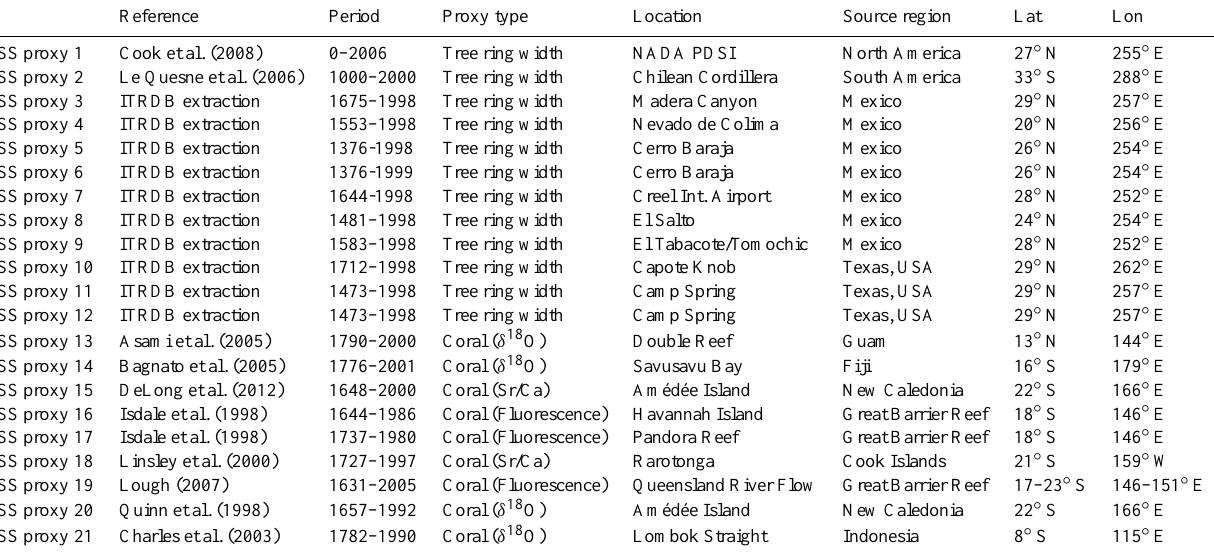
Table 3. The single station (SS) temperature and/or rainfall proxies employed in this study. Note that these proxies have at least annual resolution and are pre-screened such that they have a correlation of at least 0.3 with the annual mean (July–June) observations of ENSO, represented by Niño 3.4 area-averaged (hereafter N34, 5 ◦ S–5 ◦ N, 120 ◦ W–170 ◦ W) SST anomalies (Table 4). This correlation cutoff ensures that the proxies provide a reasonably skillful estimate of ENSO variability over the instrumental epoch.